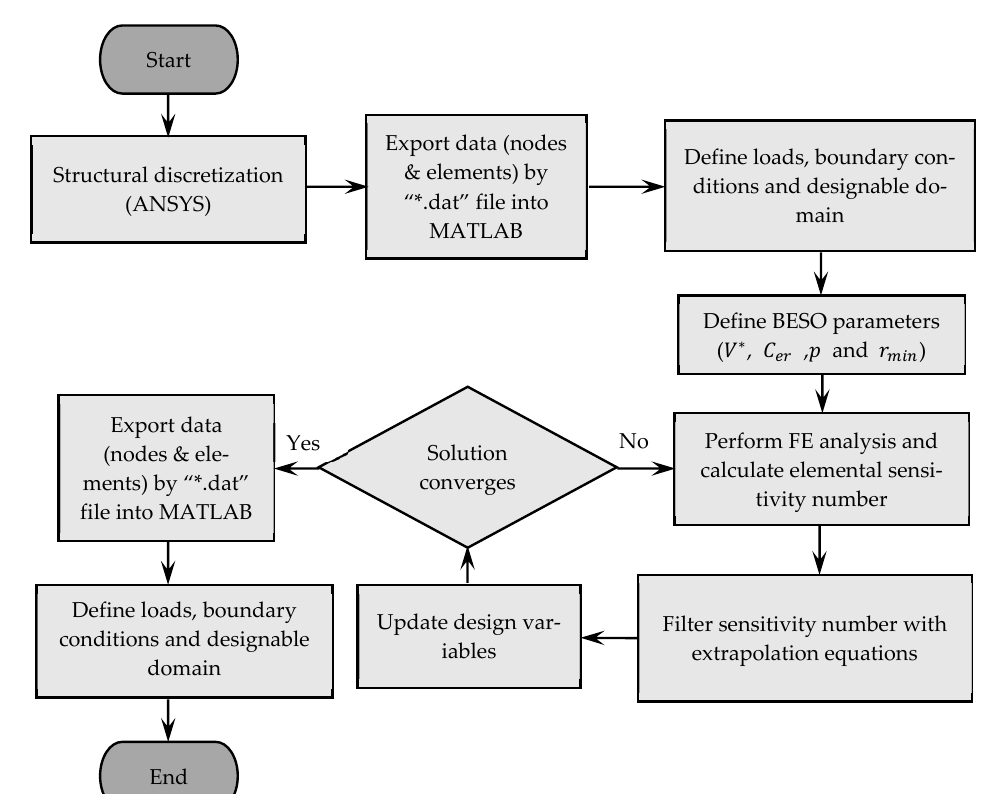
Figure 6. Topology optimization framework for optimal stiffener plate designs.